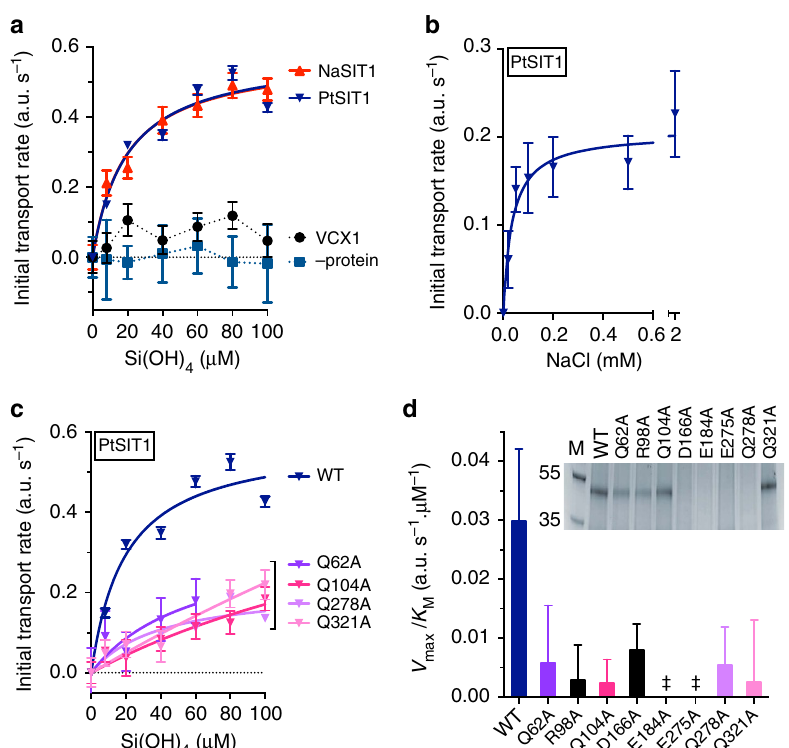
Figure 5 | Transport kinetics of SIT proteoliposomes. ( a ) Silicic acid dependence. ( b ) Sodium dependence of PtSIT1 at 40 m M silicic acid. ( c ) Silicic acid transport is diminished by mutations at conserved glutamines as shown. For panels a – c , each datapoint is mean ± s.e.m from a linear fit to the average of four technical replicates ( d ). Transport activity of WTversus mutants. ( z ), not determined because data could not be fit to the Michaelis–Menten equation. Inset, Coomassie-stained SDS–PAGE gel of purified mutants. Data are mean ± s.e.m from fitting to the Michaelis–Menten